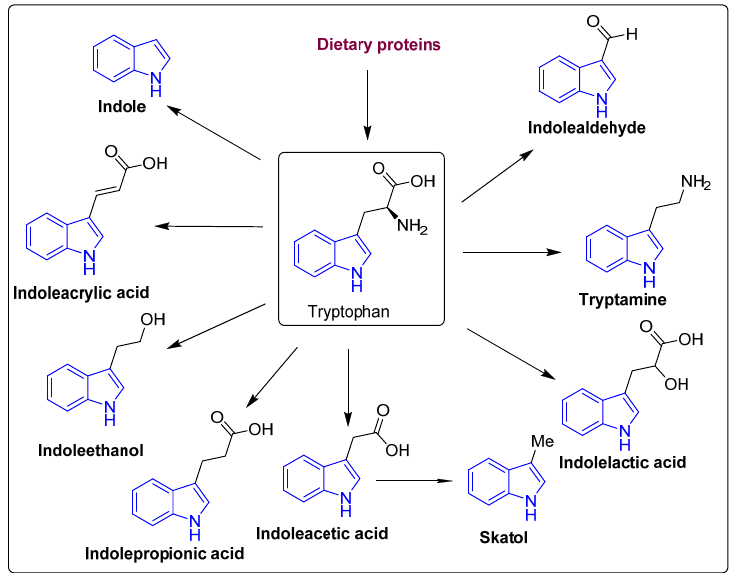
Figure 3. The structure of the tryptophan catabolites, indole, and its derivatives. Molecules 2022 , 27 , x FOR PEER REVIEW